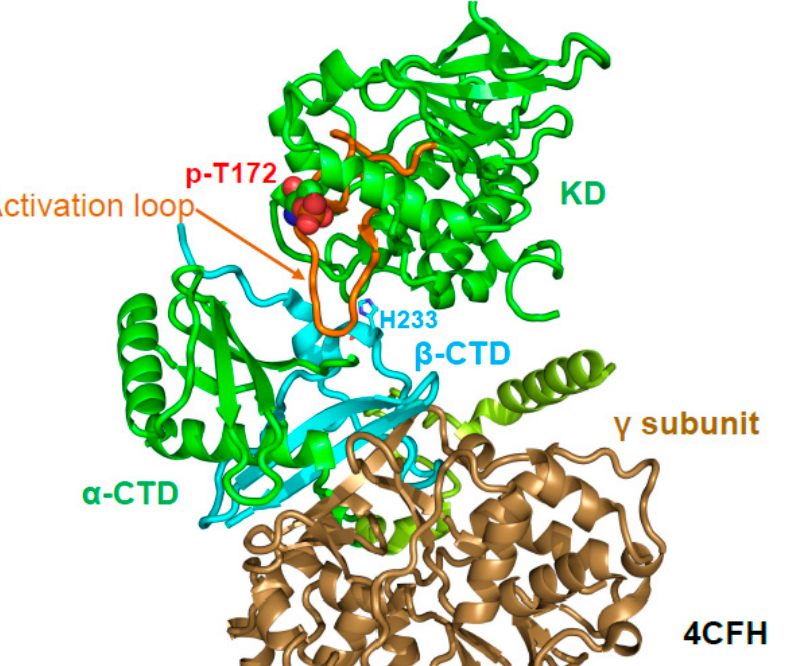
Figure 7. The β -CTD binds and stabilizes the activation loop. Structure of AMP-bound, phosphorylated AMPK α 1 – β 2 CTD– γ 1 (PDB: 4CFH). The activation loop is highlighted in orange, and p-T172 is shown in sphere presentation.